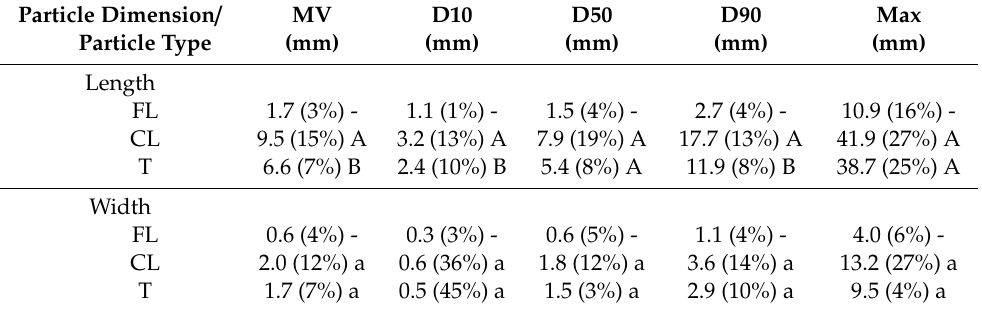
Figure 4. Histogram (blue columns) of the density distribution (primary x -axis) and line chart of the cumulative distribution (secondary x -axis) of the particle length and width distribution of the di ff erent particle types (FL, CL, and T, where CL and T have the same axis scales) obtained by image analysis. Table 5. Characteristic values of the particle length and width distribution after image analysis and their coe ffi cient of variance (in brackets) over the repeat measurements with results (homogeneous groups, indicated by letters, upper case for length and lower case for width) of statistical mean value comparison for the core layer particles CL and T. (D10 = 10% quantile, D50 = 50% quantile, D90 = 90% quantile, and Max = maximum).